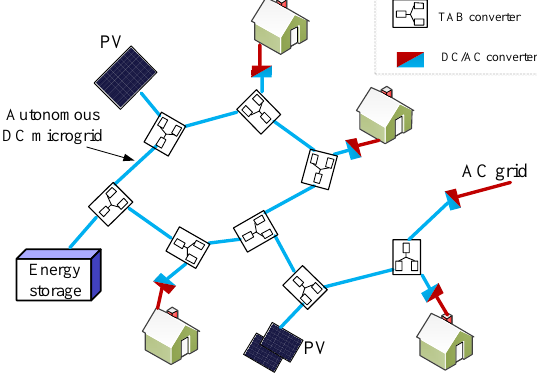
Figure 11. TAB converter for an autonomous DC microgrid